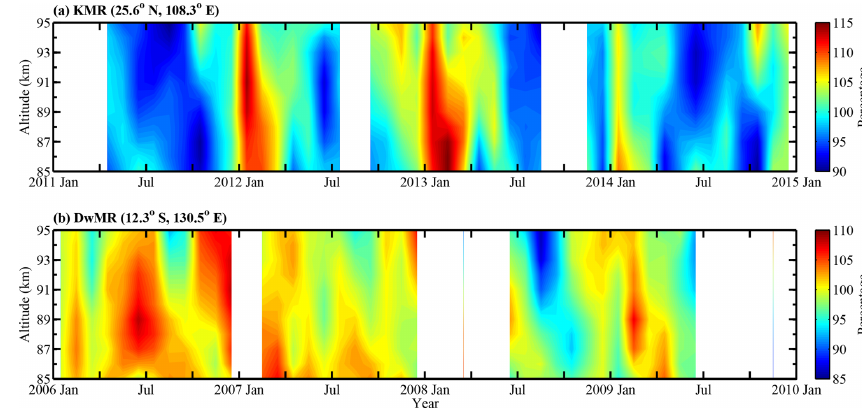
Figure 7. Same as Fig. 3 but for the KMR and DwMR monthly mean relative densities at low latitudes.